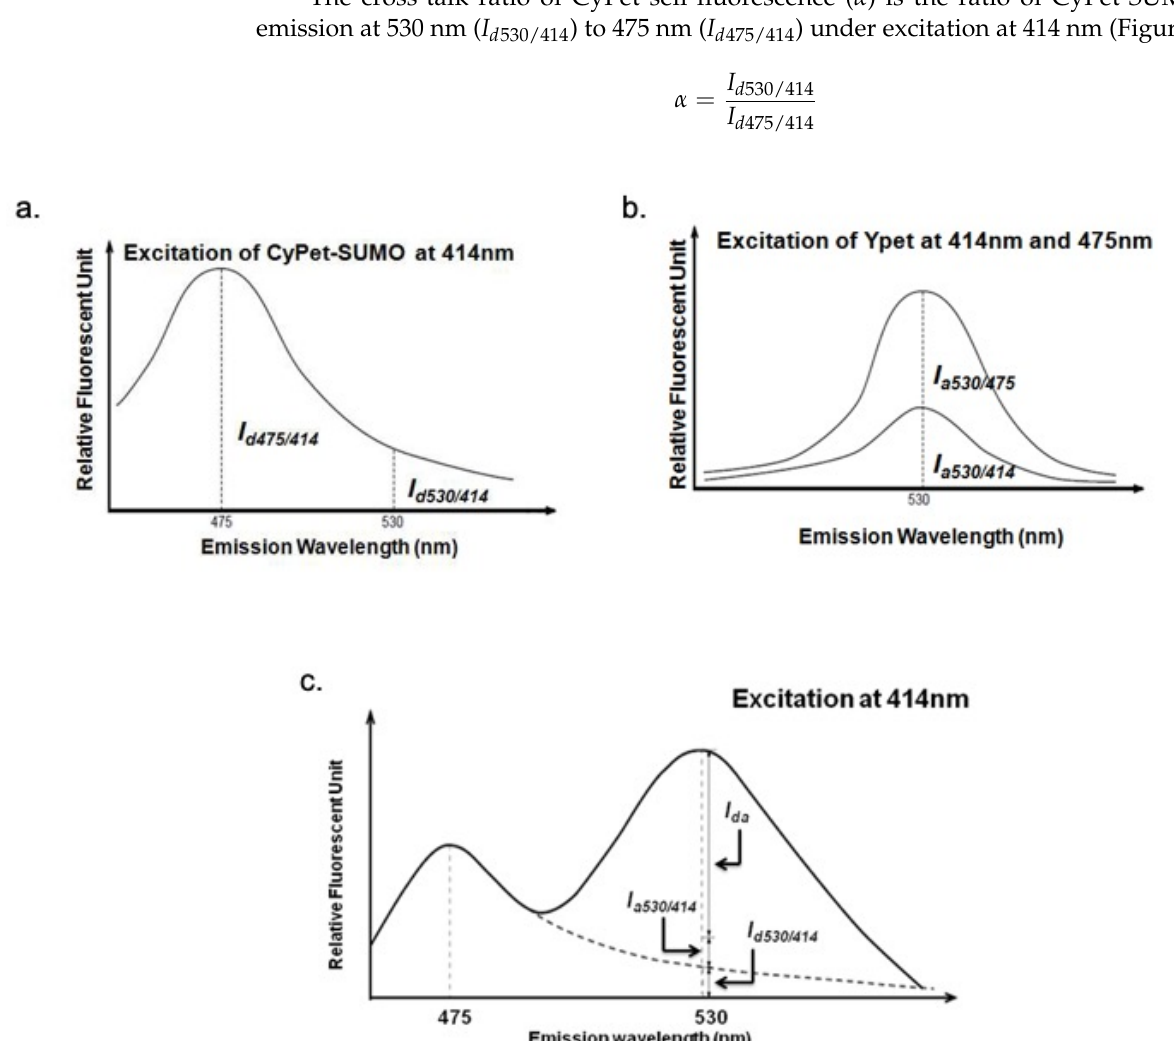
Figure 5. Quantitative analysis of fluorescent signals. ( a ) Determination of α factor using CyPet-SUMO1; ( b ) determination of β factor using YPet; ( c ) fluorescent emission at 530 nm at the excitation wavelength of 414 nm ( FL 530/414 ) can be divided into three components: FRET-induced YPet emission ( I da ), direct emission of unquenched CyPet ( I d 530/414 ), and direct emission of YPet ( I a 530/414 ).